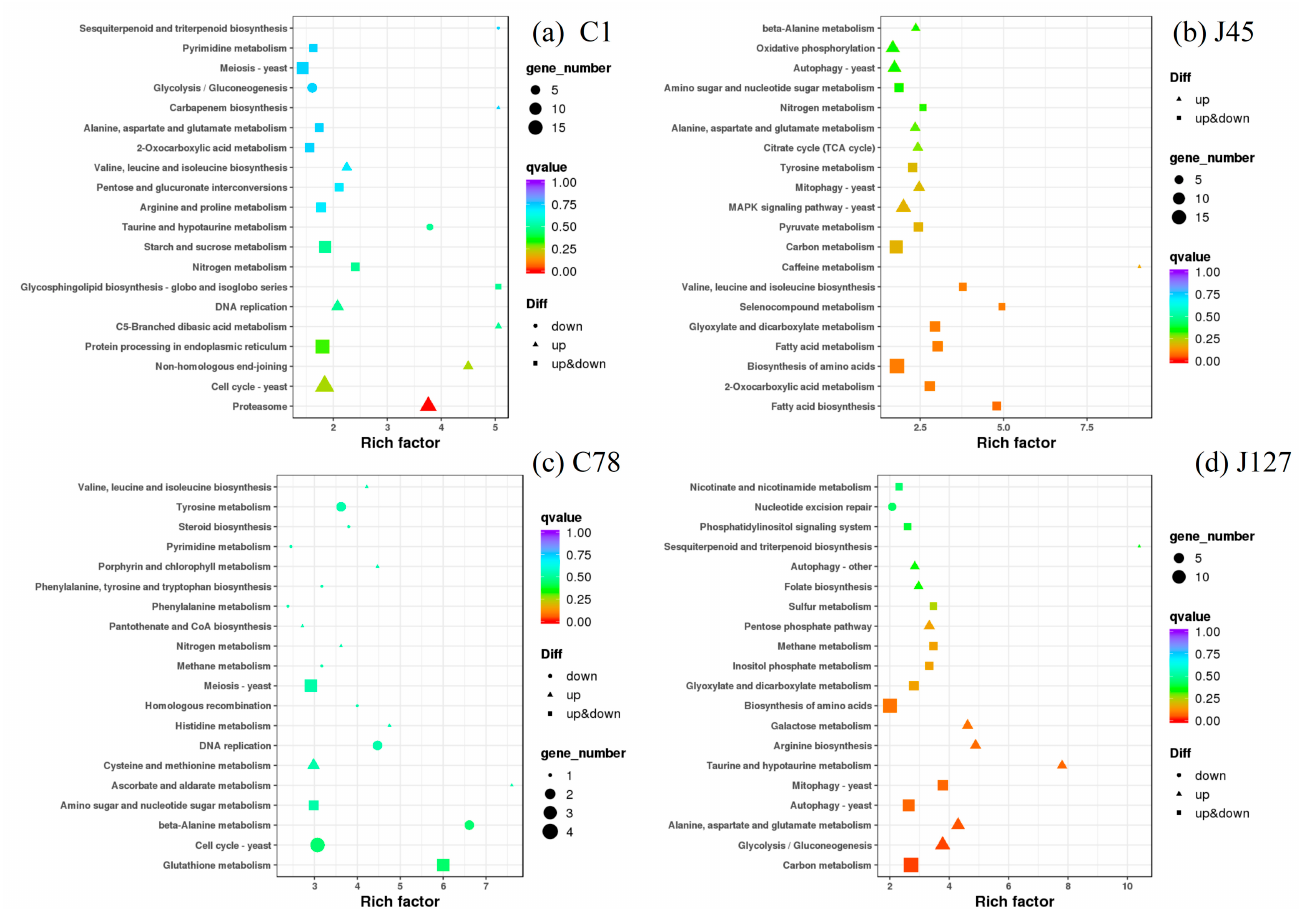
Figure 8. KEGG enrichment analysis of the DEGs in four strains (C1, J45, C78, and J127) of C. geophilum after 2 mg/L Cd treatment as compared to the same strains cultured in normal conditions (0 mg/L Cd). Each symbol (circle, square, and triangle) in the figure represents a KEGG pathway, the ordinate indicates the name of the pathway, and the abscissa is the enrichment factor. The size of the symbol represents the numbers of DEGs involved in the corresponding